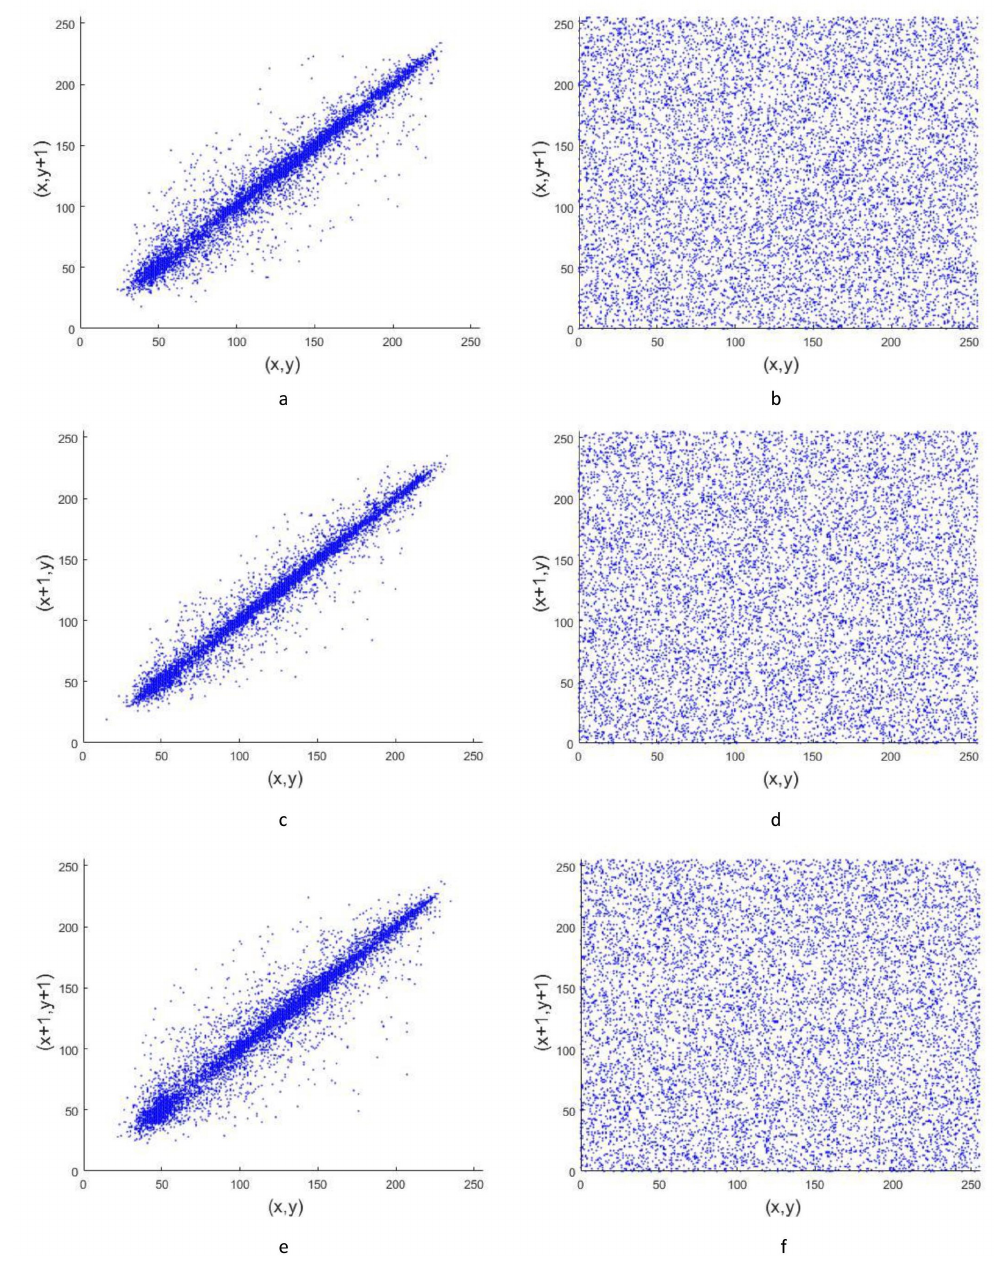
Figure 13. Distributions of adjacent pixels in original image and encrypted image of Lena. ( a , c , e ) are distributions of original image in horizontal, vertical, and diagonal directions, respectively. ( b , d , f ) are distributions of encrypted image in horizontal, vertical, and diagonal directions,